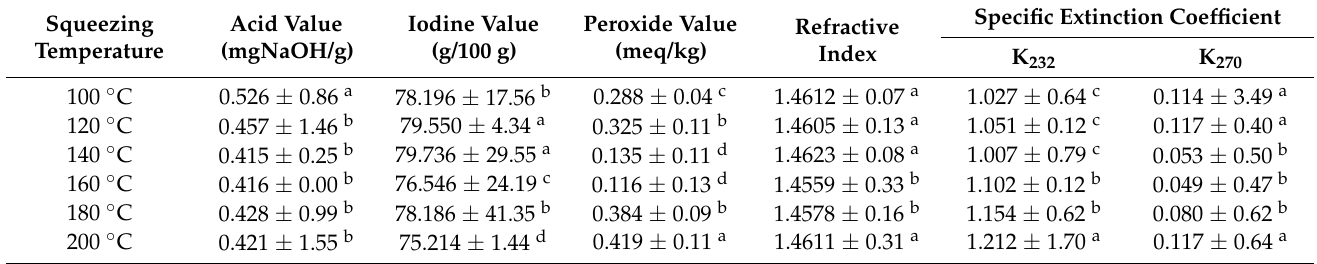
Table 3. Effect of different pressing temperatures on the physicochemical properties of cashew nut kernel oil.